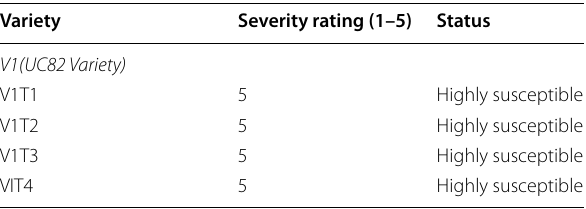
Table 7 Bacterial wilt severity ratings and status of tomato plants in the 11 th week after